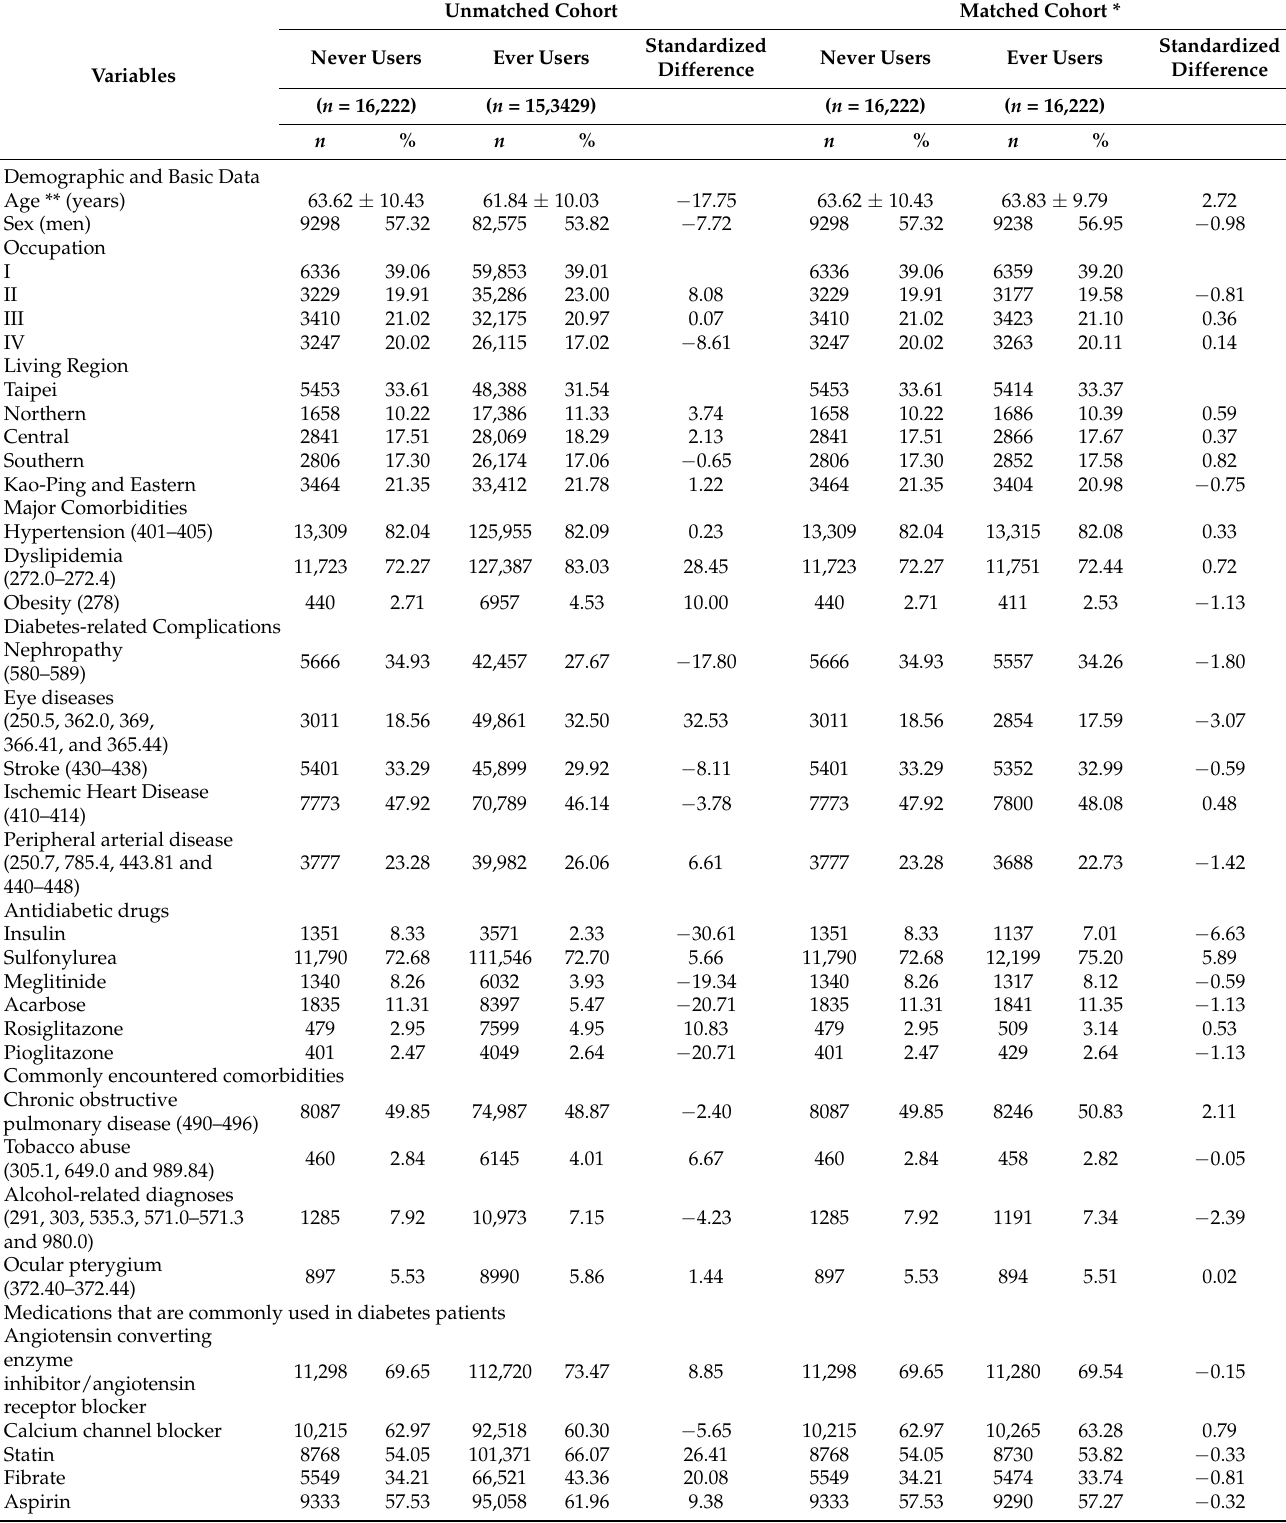
Table 1. Characteristics of metformin never users and ever users and standardized difference between the two